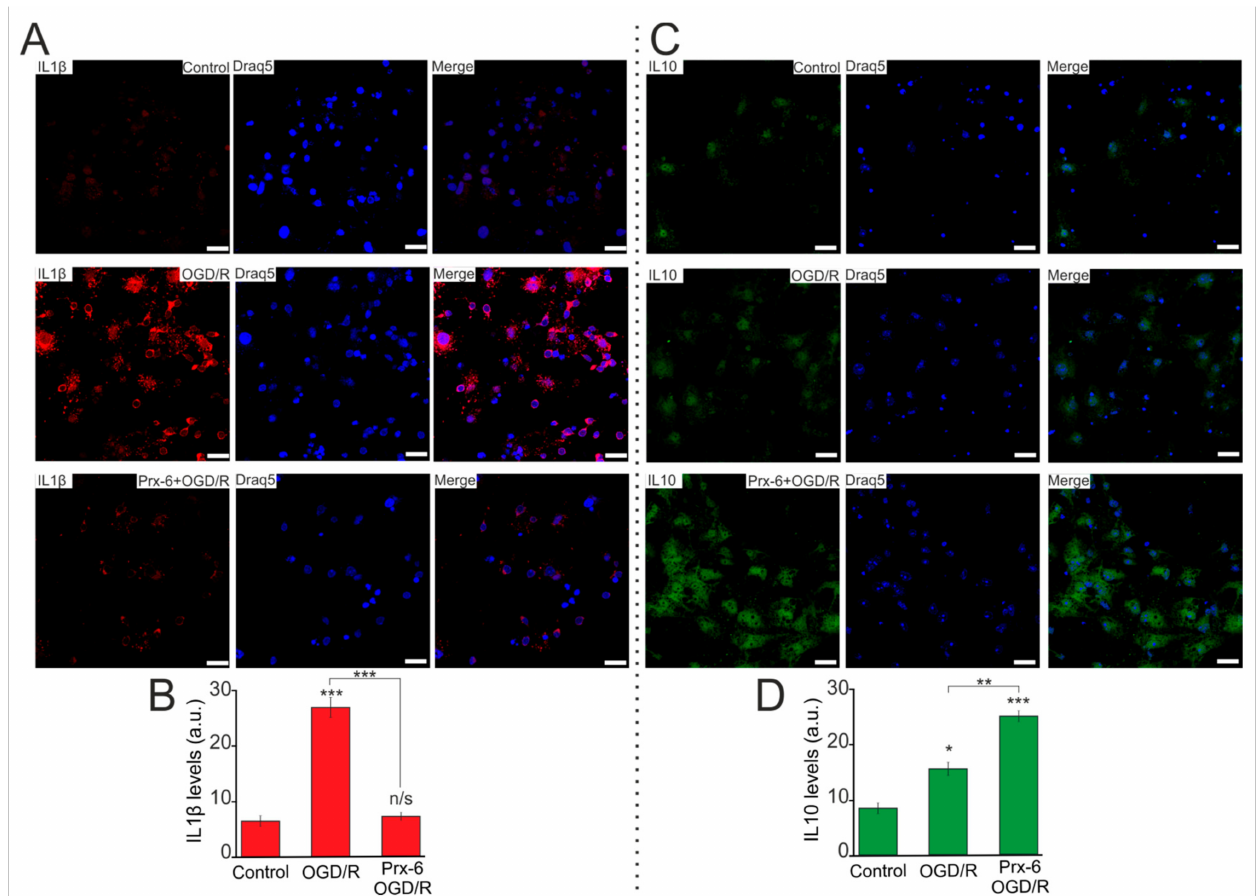
Figure 8. Effect of 24-h incubation of hippocampal cells with Prx-6 (100 µ M) on the protein level of IL-1 β and IL-10 in Control, after OGD/R and OGD/R with Prx-6. A, C—Immunostaining of IL-1 β ( A ) and IL-10 ( C ) of hippocampal cells in the control (without OGD/R), after 40 min OGD (OGD/R) and 24h reoxygenation and 24 h incubation with 100 µ M Prx-6, 40 min OGD and 24-h reoxygenation (designated as Prx-6 + OGD/R). Draq5—nuclei staining. ( B , D ) Intensity levels of IL-1 β and IL-10 were determined by confocal imaging. We analyzed individual cells which had fluorescence of secondary antibodies. The quantative data reflecting the level of IL-1 β ( B ) and IL-10 ( D ) expression are presented as fluorescence intensity values in summary bar charts (mean ± SEM). The values were averaged by 150 cells for each column. The results obtained after immunostaining agree well with the data of fluorescent presented in panels A and C . Each value is the mean ± SE ( n ≥ 3, p < 0.05). Statistical significance was assessed using paired t -test. Comparison with OGD/R, *** p -level < 0.001, ** p -level < 0.01, * p -level < 0.05, n/s—data not significant ( p > 0.05). Comparison Control with Prx6 + OGD/R, * p -level < 0.05. Scale bar = 25 µ